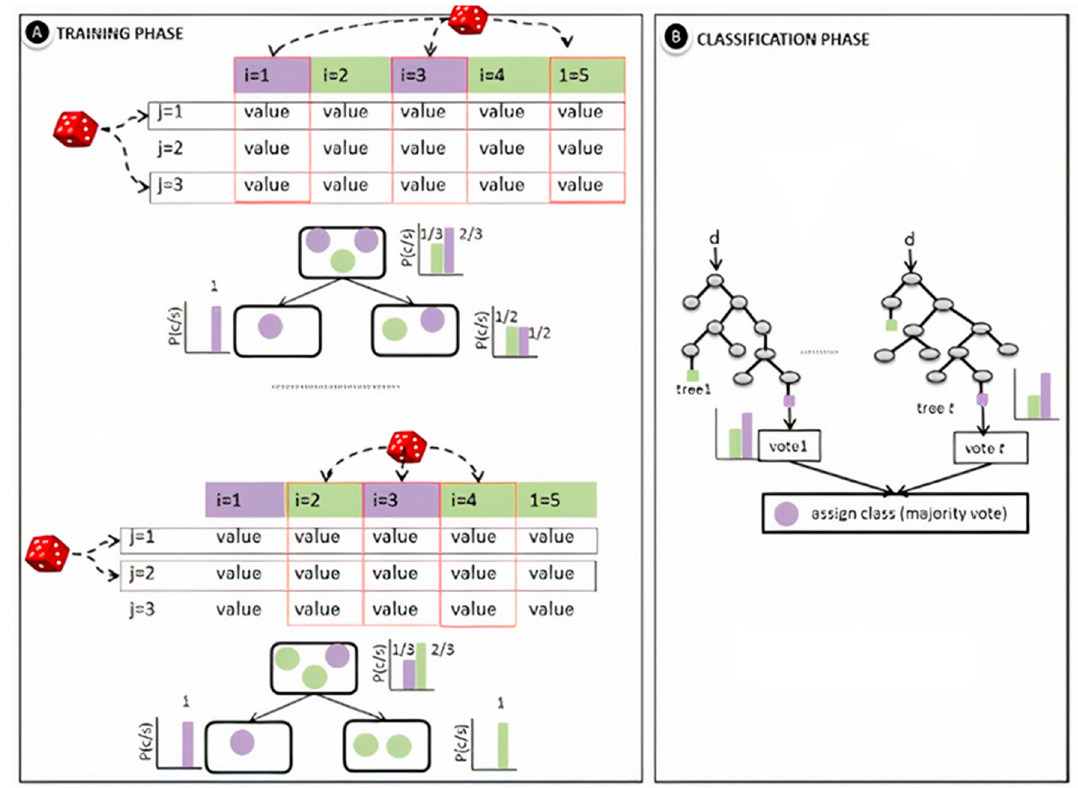
Figure 3. Training and classification phases of Random Forest classifier: i = samples, j = variables, p =probability, c = class, s = data, t = number of trees, d = new data to be classified, and value = the different values that the variable j can have [19].